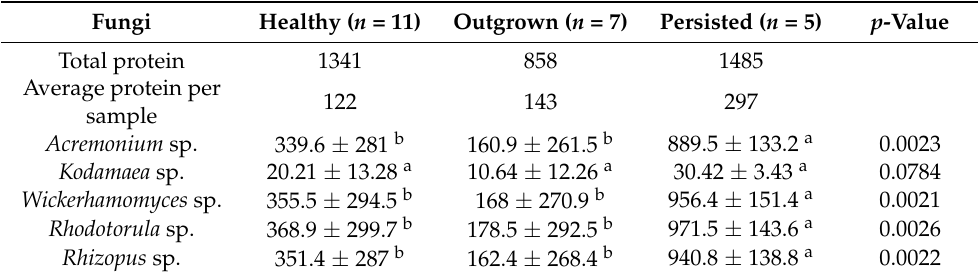
Table 3. Number of proteins from five fungi with more than 50% prevalence level per group. Fungi